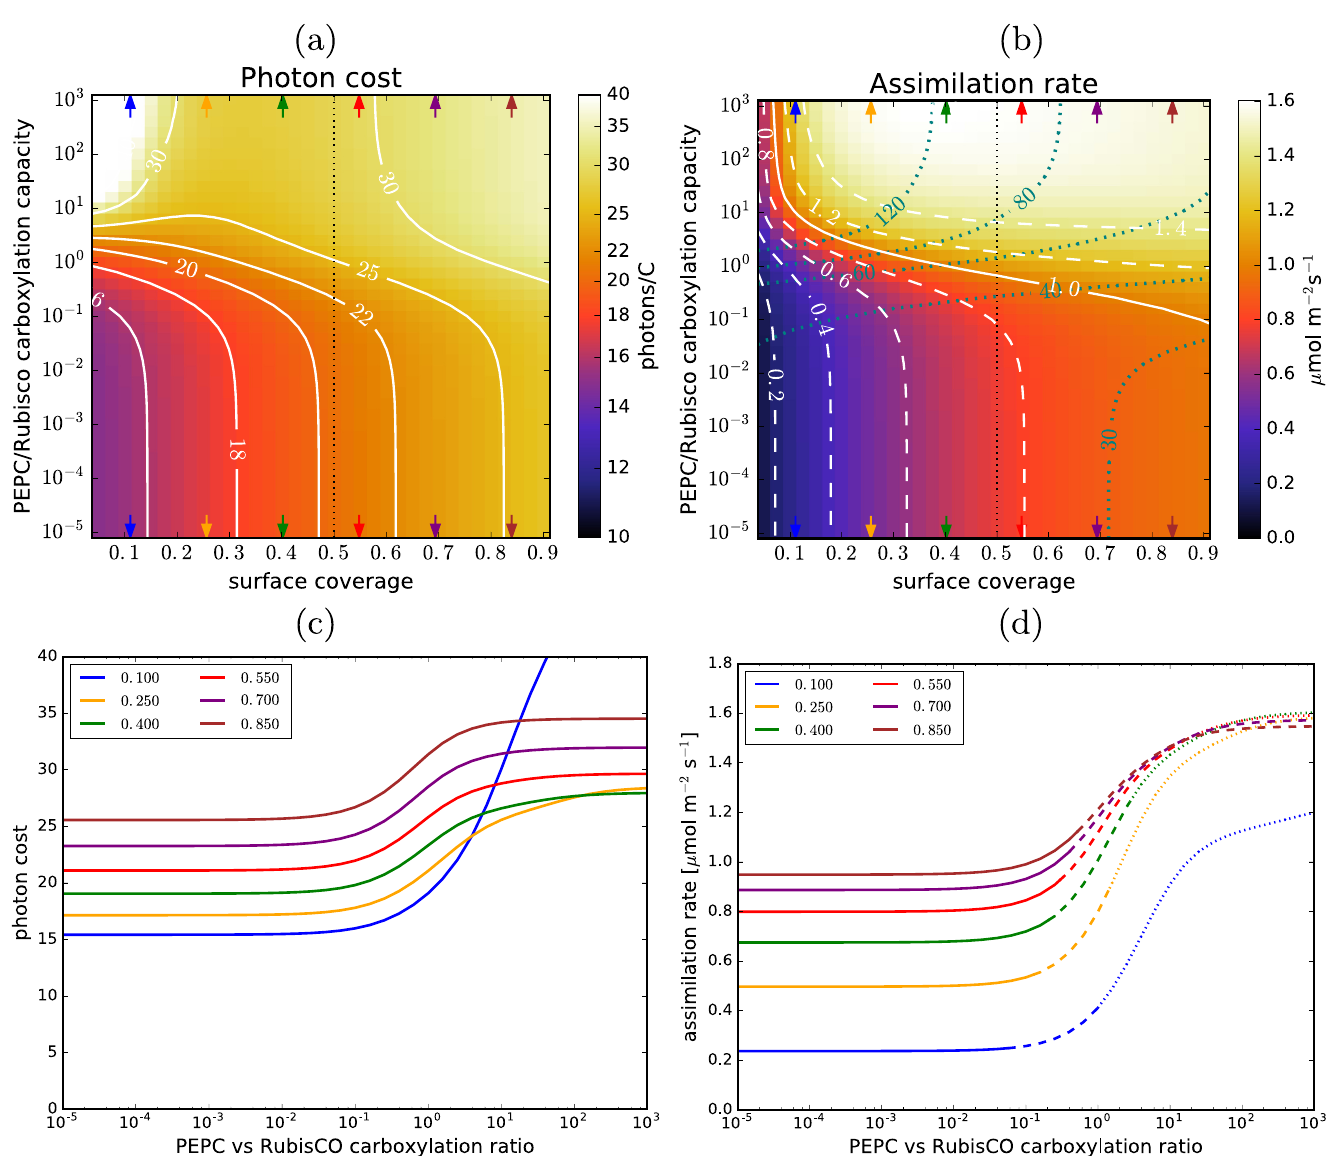
Fig 4. Chloroplast surface coverage and C 4 photosynthesis. (a) and (b): The photon cost and the net assimilation rate as functions of the chloroplast surface coverage and PEPC-to-RubisCO carboxylation capacity ratio, for the default parameter choice (Table 1). Level-lines are in white. The blue lines in (b) mark the light-utilisation thresholds (in mol m -3 s -1 ). The carboxylation capacity ratio is used instead of the PEPC concentration to quantify the C 4 cycle activity because the cytoplasmic volume per chloroplast changes with the coverage. The black vertical dotted line marks the surface coverage used as default in other figures. (c): Dependence of the photon cost on the PEPC-vs-Rubisco carboxylation capacity ratio for several evenly-spaced surface coverage values (marked with arrows in (a) and (b)). (d): The corresponding dependence of the assimilation rate. The lines turn dashed (dotted) where the required light-harvesting capacity exceeds 40 mol m -3 s -1 (80 mol m -3 s -1 ).